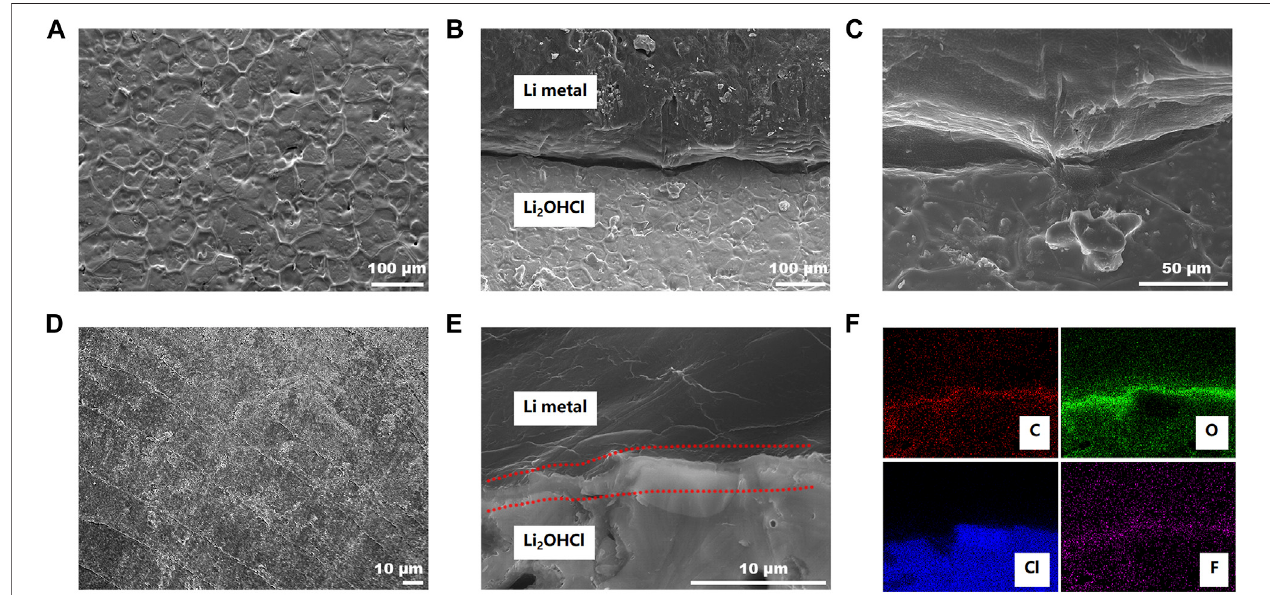
FIGURE 4 | The morphology of the surface (A) and cross-sectional (B,C) of the Li 2 OHCl pellet after galvanostatic cycling for 20 h in a Li/Li2OHCl/Li cell without LE optimization. The morphology of the surface (D) and cross-sectional (E) of the Li 2 OHCl pellet after galvanostatic cycling for 20 h in an Li/Li2OHCl/Li cell with LE optimization. (F) Energy-dispersiveX-rayspectroscopy(EDS)mappingimagescorrelatedtothe fi gure (E) ofthecarbon,oxygen,chlorine,and fl uorineinred,green,blue, and purple,